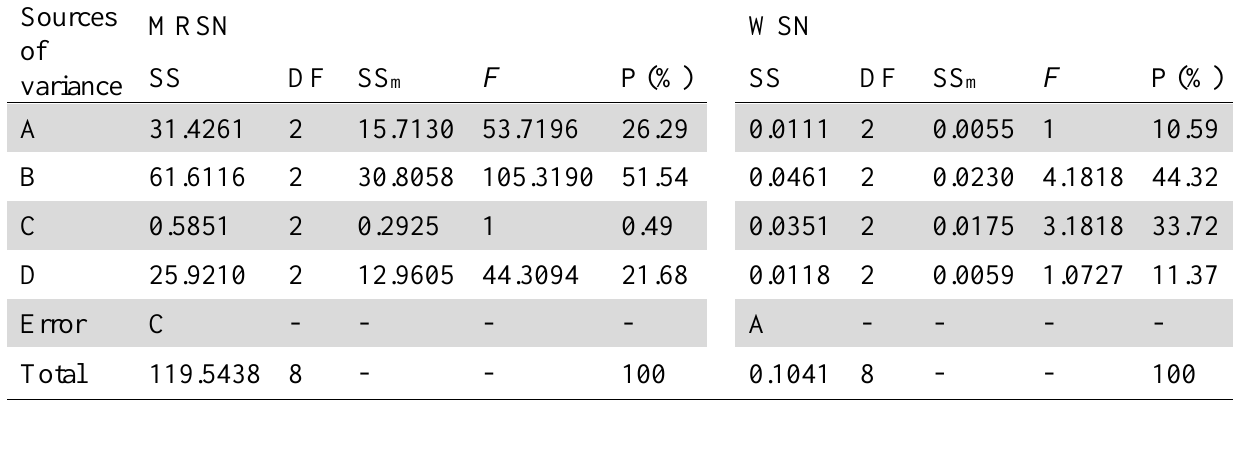
Results of ANOVA for MRSN, and WSN